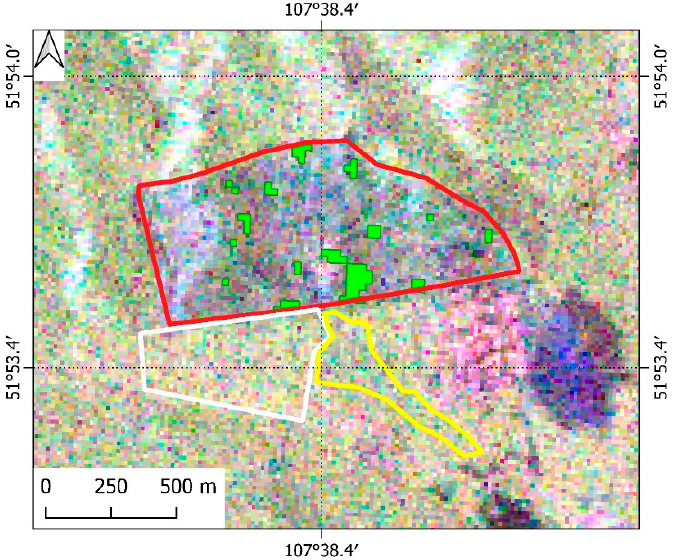
Figure 4. Pauli RGB color composite with Н - α classification results overlaid (green filled polygons). 30 August 2019.